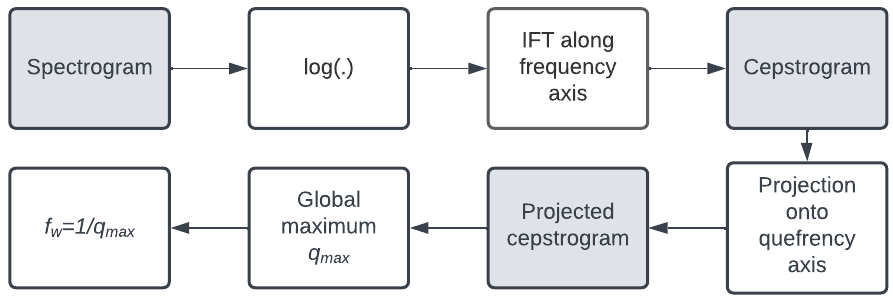
Figure 5. Steps for automatically extracting the wingbeat frequency from the radar